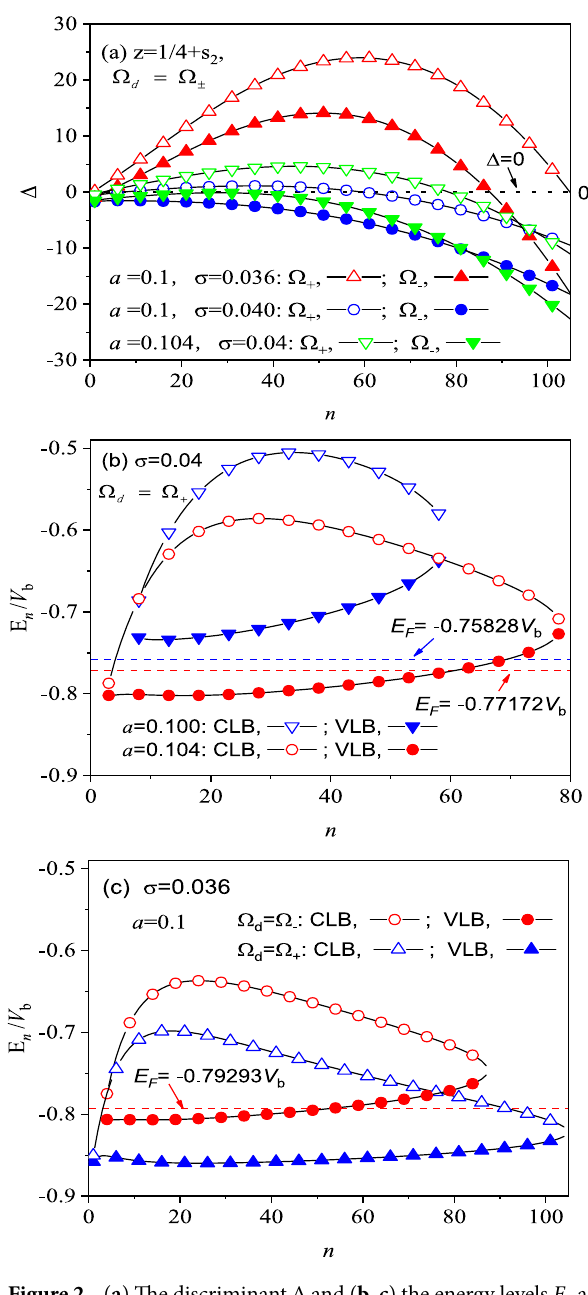
Figure 2. ( a ) The discriminant Δ and ( b , c ) the energy levels E n as a function of n at z various a and σ. Fermi energy is defined by E F in ( b ) and ( c